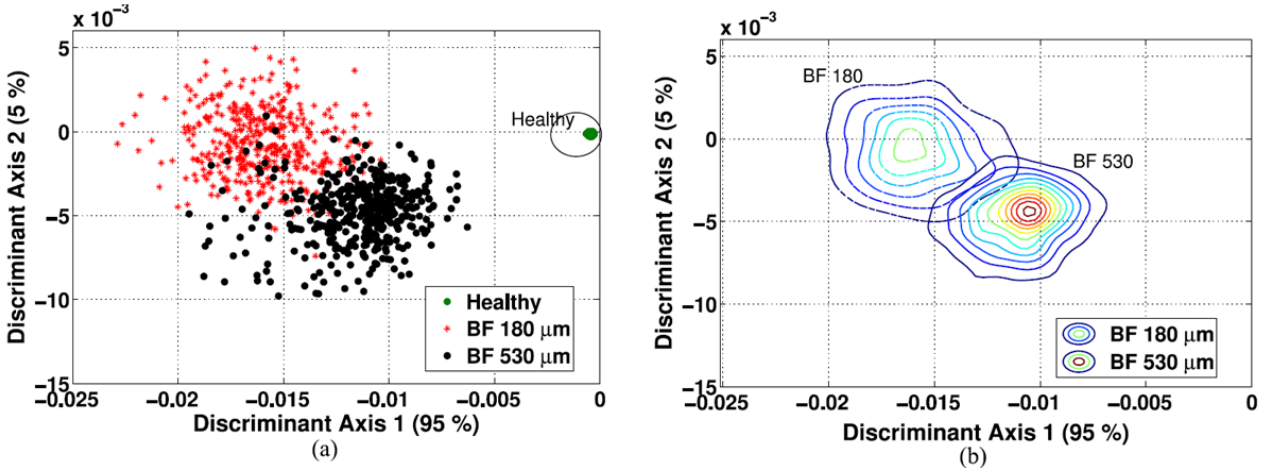
Figure 31. ( a ) Discrimination of bearing faults by LDA; ( b ) contour of PDF for estimated class of ball bearing fault [79].